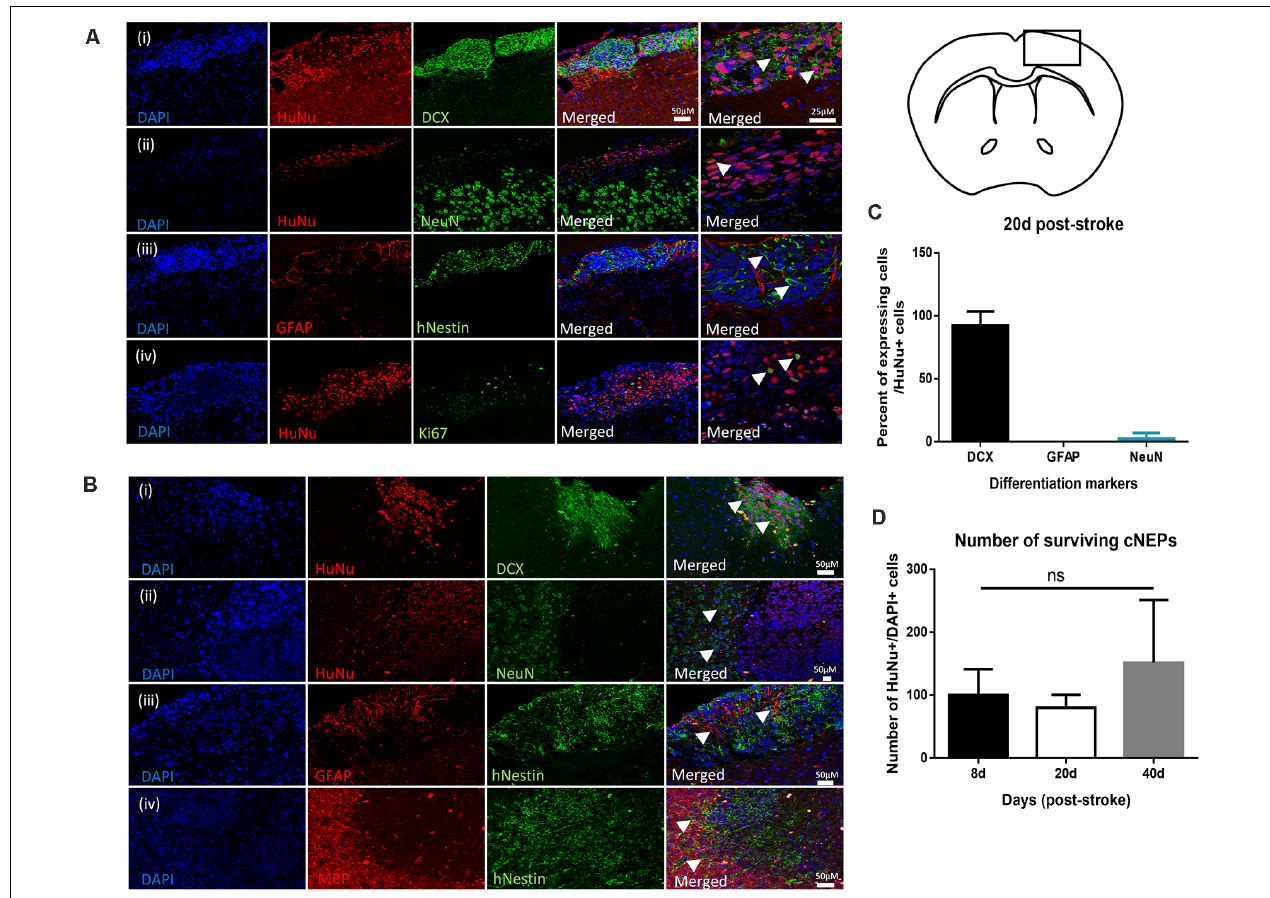
FIGURE 3 | Transplanted CNEPs express doublecortin, a marker of immature neurons. (A) Coronal schematic of forebrain at PSD20 HuNu + or hNestin + transplanted cNEPs express DCX (i) , low levels of NeuN (ii) and are GFAP negative (iii) . A small number of cells express Ki67 (iv) . Scale bar = 25 µ m. (B) By PSD40, HuNu + or hNestin + transplanted cNEPs express DCX (i) , but do not colocalize with mature cell markers NeuN (ii) , GFAP (iii) or MBP (iv) . Scale bars = 50 µ m. (C) Quantification of the differentiation phenotype of HuNu + cNEP cells in the PSD20 brain showing majority of transplanted cells are DCX + immature neurons. ( n = 3 mice). (D) The total numbers of HuNu + /DAPI + cells showed no significant difference between the numbers of surviving cells on PSD8 ( n = 3 mice), PSD20 ( n = 3 mice) or PSD40 ( n = 9 mice). Data represents mean ± SEM. One-way ANOVA, Tukey’s post hoc ; ns, not significant. Arrowheads indicate cells expressing mature or immature neuronal